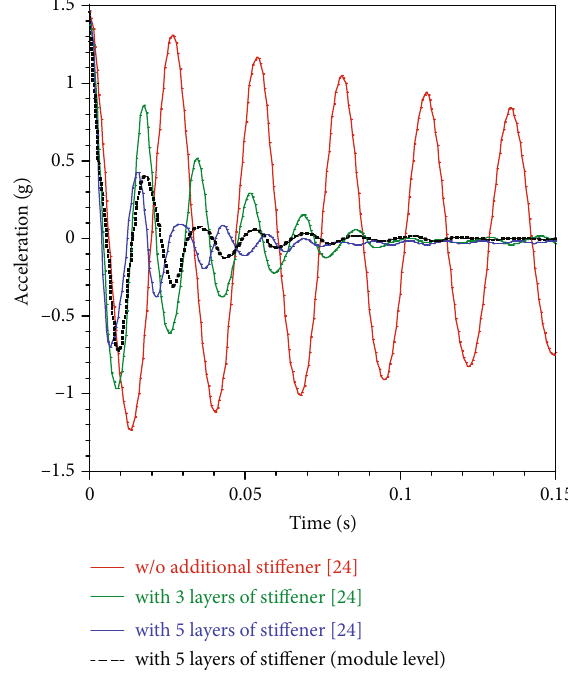
Figure 5: Time histories of the free-vibration tests of solar panels with various numbers of sti ff